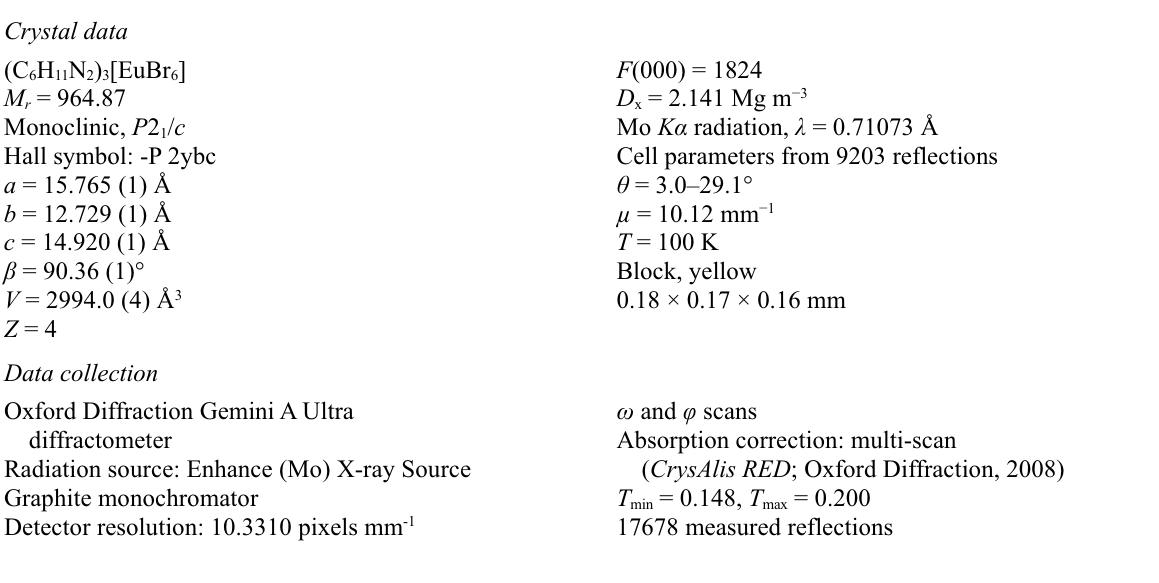
[EuBr ] viewed along the b axis. The [EuBr 3 6